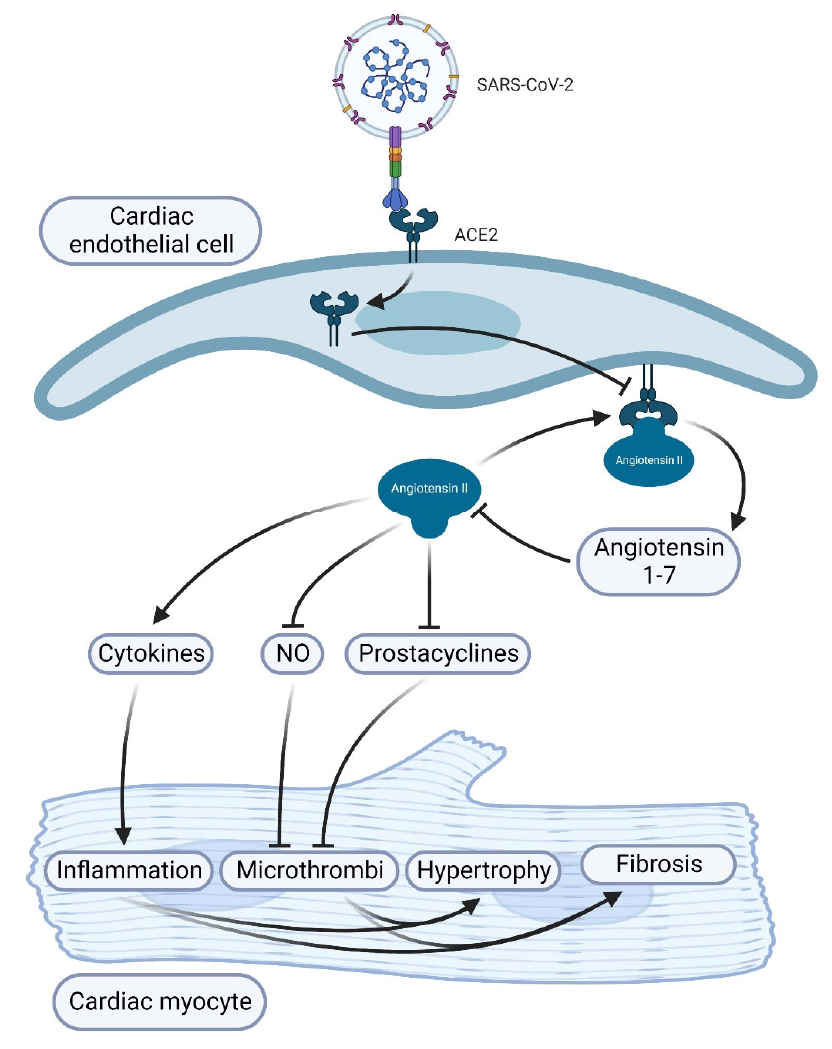
Figure 2. Indirect myocyte damage from COVID ‐ 19 infection. COVID ‐ 19 viruses enter endothelial cells when the spike protein binds to the ACE2 receptor. The receptor with virus is brought into the cell, leading to overall reduction in ACE2 receptor expression in the plasma membrane. ACE2 reg ‐ ulates angiotensin II activity when angiotensin II binds to the receptor, causing angiotensin II deg ‐ radation and the production of angiotensin 1–7. Angiotensin 1–7 also acts to inhibit angiotensin II activity. Reduction of ACE2 receptor presence leads to decreased angiotensin II inhibition. Angio ‐ tensin II causes damage to cardiac myocytes through cytokine ‐ induced inflammation and facilitat ‐ ing microthrombi formation through inhibition of vasodilators such as nitric oxide (NO) and pros ‐ tacyclin. Inflammation and ischemic injury lead to myocyte hypertrophy and fibrosis. Figure cre ‐ ated with BioRender.